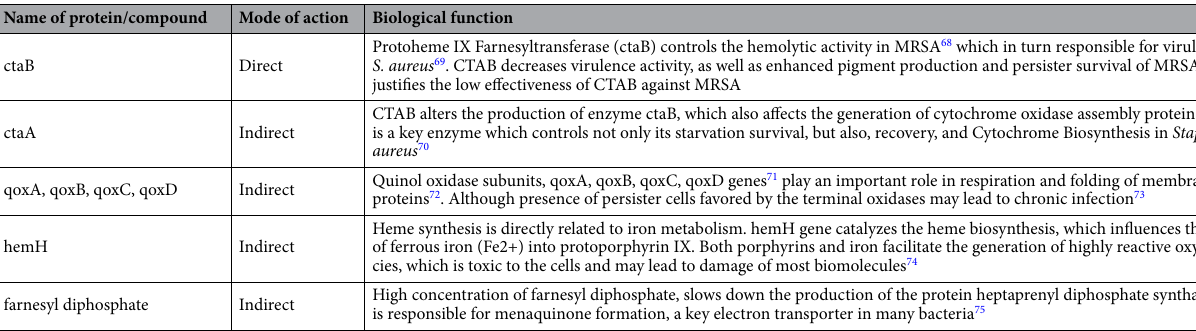
Table 4. Effect of cetyltrimethyl ammonium bromide (CTAB) on MRSA.